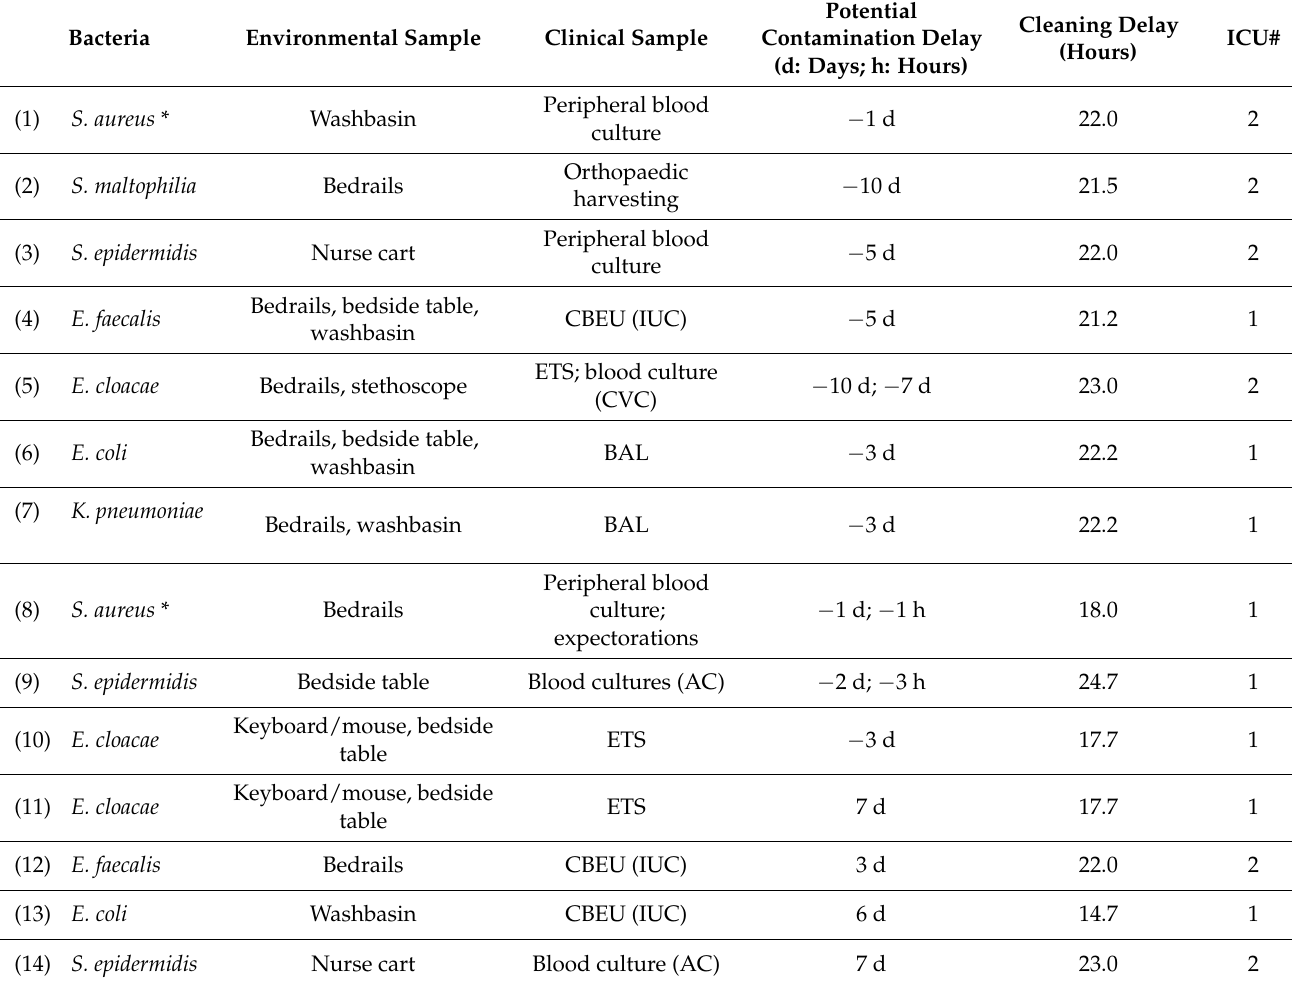
Table 2. Potential contaminations from the patient to the environment (from 1 to 10) and from the environment to the patient (from 11 to 14). The delay was calculated with respect to the environmental sampling; therefore, it was negative when patient sampling preceded it and positive when patient sampling followed it (CBEU: cytobacteriological examination of urine ; IUC: indwelling urinary catheter; AC: arterial catheter ; CVC: central venous catheter ; ETS: endotracheal suctioning; BAL: bronchoalveolar lavage; AC: arterial catheter ) (bacteria of interest (*) were all